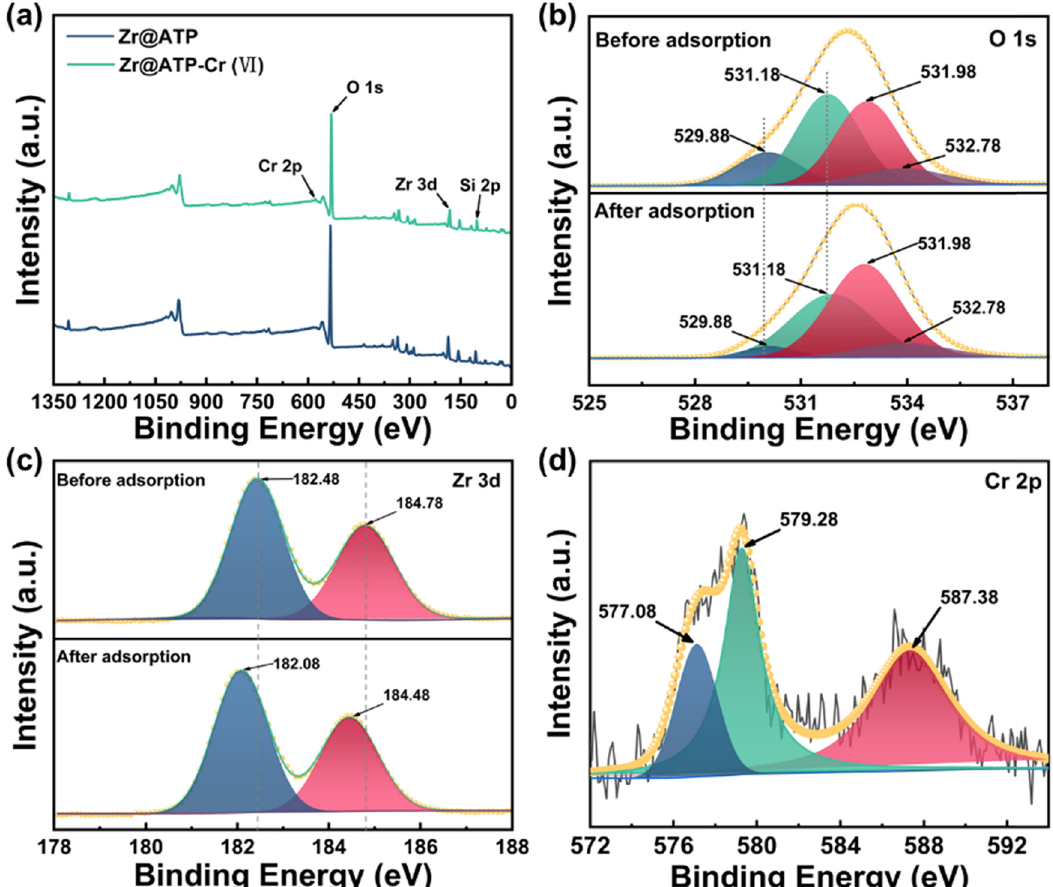
Figure 5: The ( a ) full - scan XPS spectra of Zr@ATP before and after Cr ( VI ) adsorption, high - resolution XPS spectra for ( b ) O 1s, ( c ) Zr 3d, along with ( d ) Cr